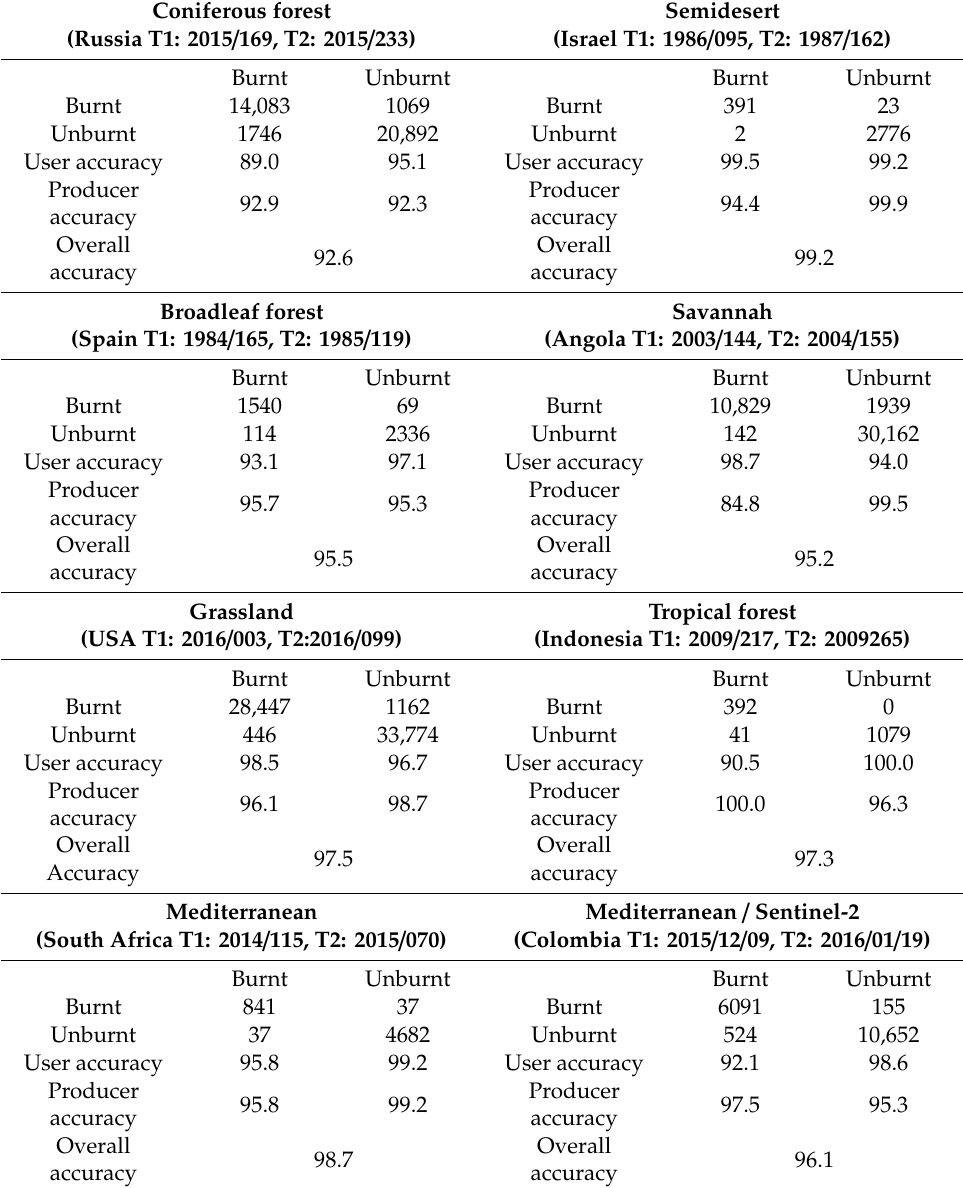
Table 3. Confusion matrices for scenes from di ff erent geographic zones and vegetation types. Acquisition dates of pre- (T1) and post- (T2) fire images are given as: year / day of year.